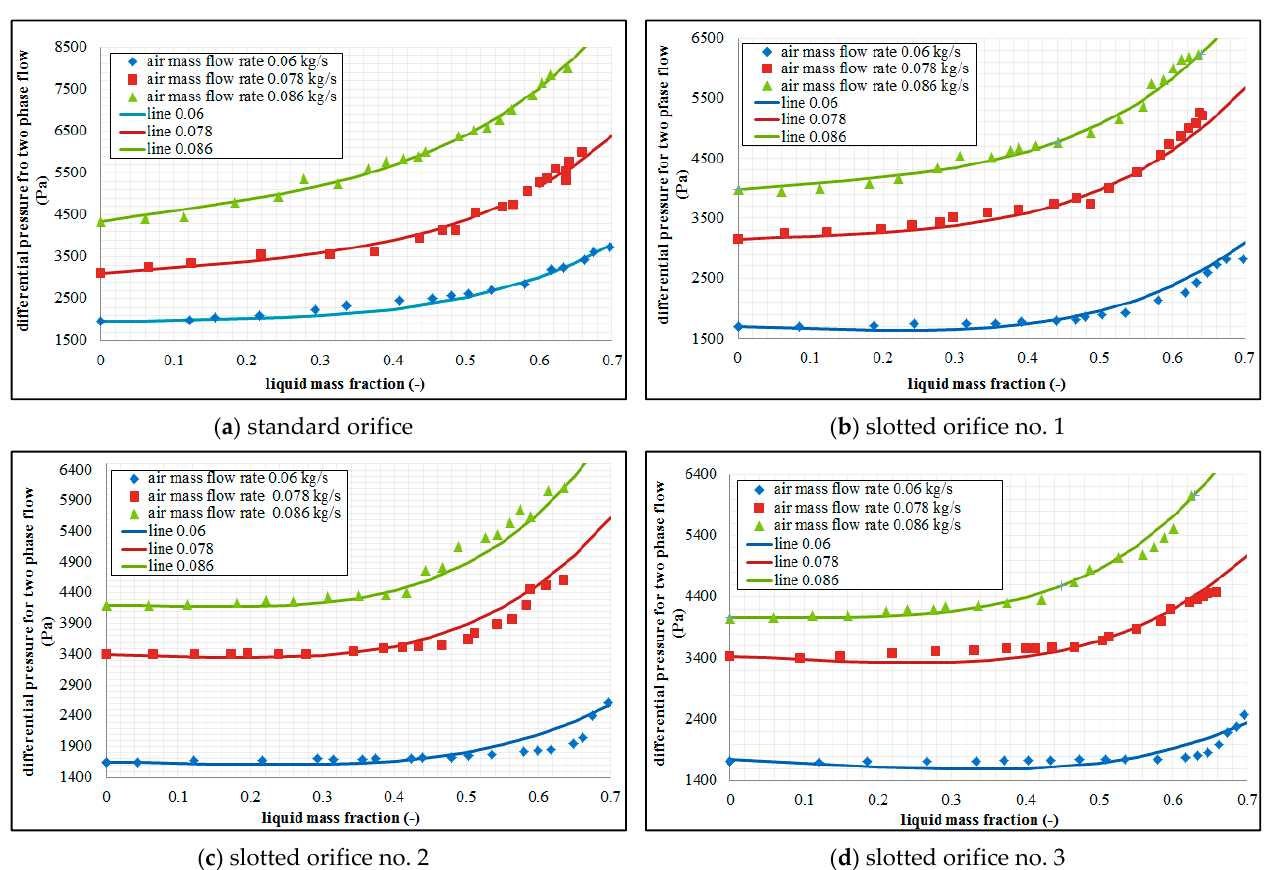
Figure 9. Dependence of differential pressure on the liquid mass fraction.